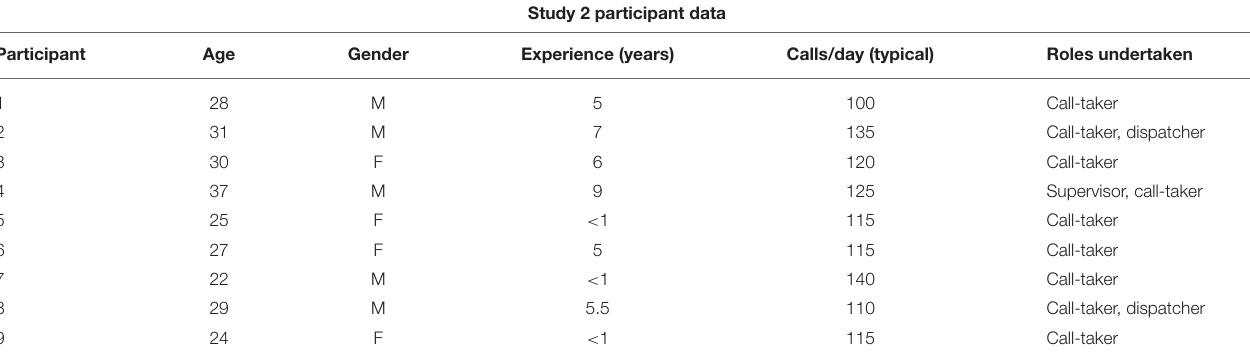
TABLE 2 | Summary of